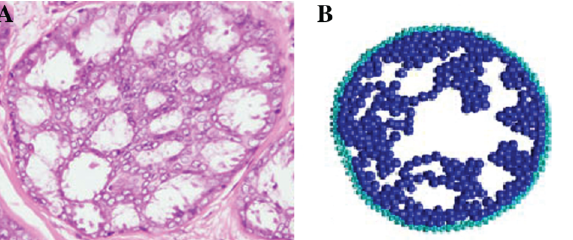
Figure 7: Simulation (B) of the cribiform variety of DCIS with the proposed parallel model, compared with a histological cut (A), with formation of crypts in the duct.